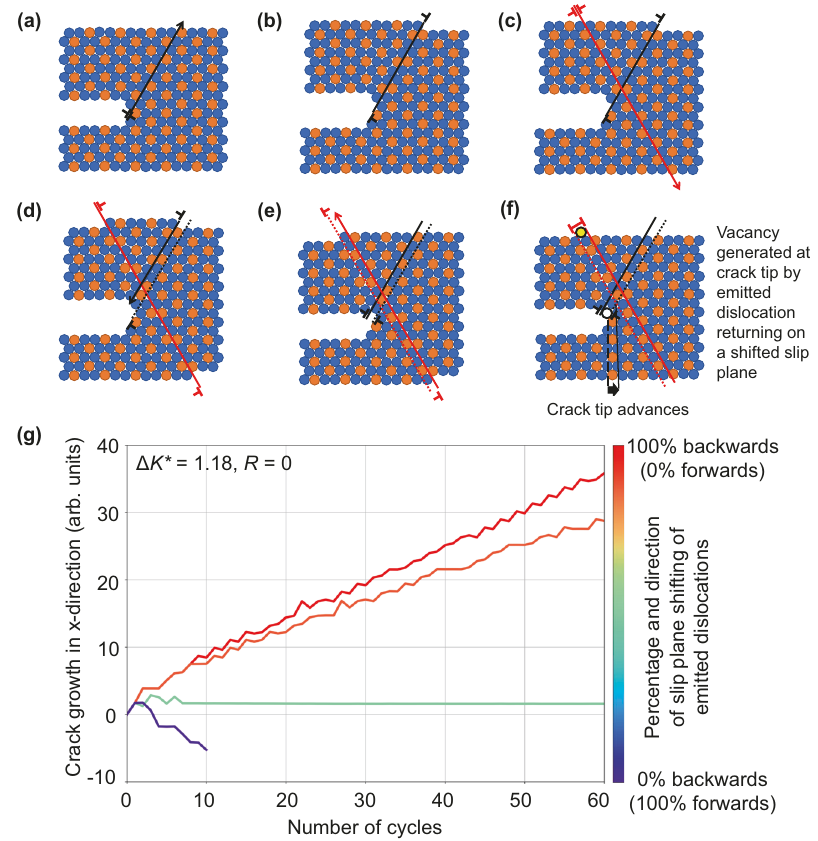
Fig. 3 Fatigue crack advance with slip trace intersection. Schematics show the sequence of dislocation nucleation ( a and b ), slip trace intersection ( c and d ), and the resulting change in slip plane when the dislocation returns and is absorbed on the unload ( e and f ). This process leads to the removal of an atom from the crack tip, highlighted in yellow in ( f ), creating a vacancy at the crack tip. Other atom colors are used to show deformation. g Crack growth vs. number of cycles with the slip plane of emitted dislocations being changed prior to their absorption into the crack on the unload. Shows that shifting the slip plane of emitted shielding dislocations backwards (in the opposite direction of crack growth) produces sustained crack growth, consistent with the schematic in ( a )-( f ). Crack closure was observed in the case when the slip planes were shifted forward, and no crack growth was observed when dislocations were shifted forward and backward in equal proportion. Distances are normalized by the magnitude of the Burgers vector, b , and the range of the normalized stress intensity factor that is used to characterize the loading amplitude, Δ K (cid:1) ¼ Δ K I = K nuc . I